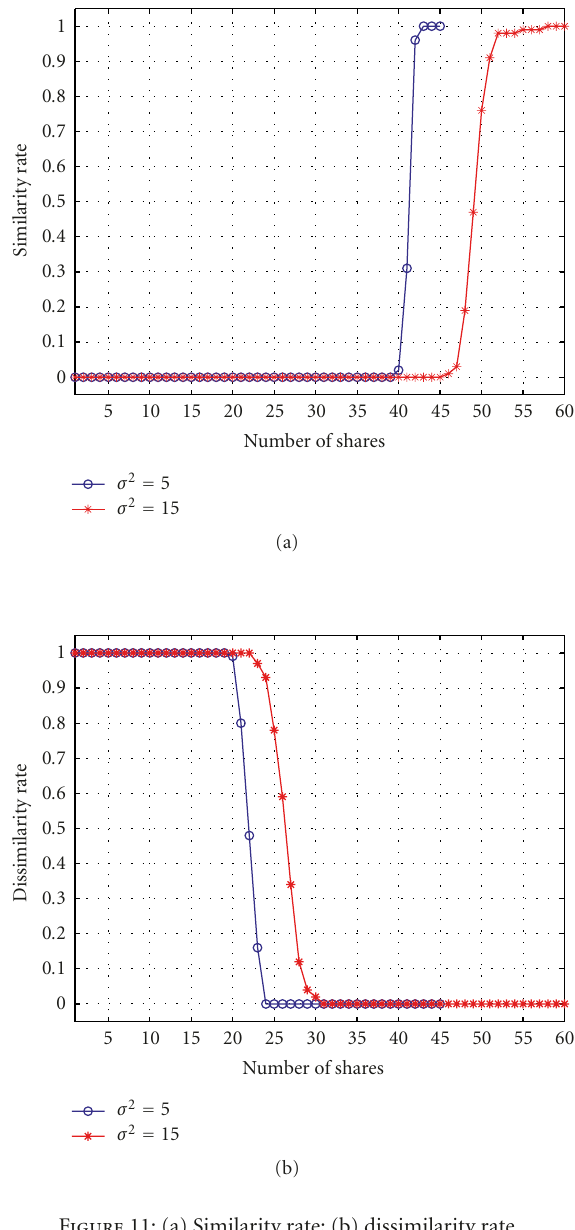
Figure 11: (a) Similarity rate; (b) dissimilarity